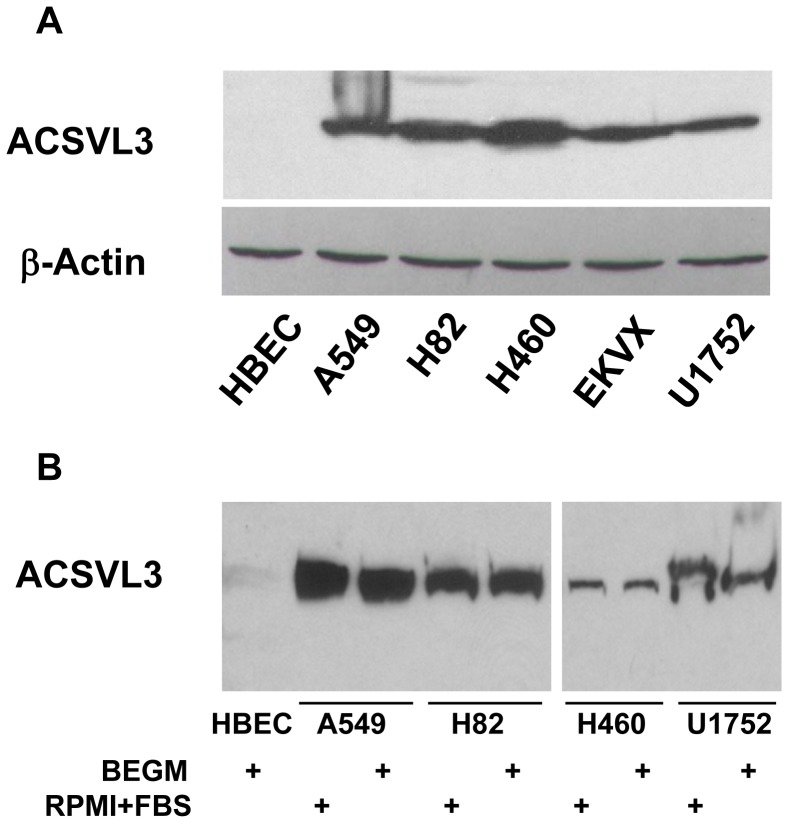
ACSVL3 expression in human bronchial epithelial cells and lung cancer cell lines.(A) Growth under standard culture conditions. HBEC and five lung cancer cell lines were cultured as described in Methods and analyzed for ACSVL3 expression by Western blot. Tumor cell lines were derived from non-small cell carcinoma (A549), small cell carcinoma (H82), large cell carcinoma (H460), adenocarcinoma (EKVX), and squamous cell carcinoma (U1752). β-Actin expression was determined as a loading control. (B) Effect of growth rate reduction on ACSVL3 expression in lung cancer cell lines. HBEC, cultured in serum-free BEGM, grow significantly slower than cancer cell lines. To slow their growth rates, A549, H82, H460, and U1752 cells were transferred to BEGM. All cells were maintained in this medium for 3 weeks, at which time they were harvested and subjected to Western blot analysis. Tumor cells grown in standard medium, RPMI plus 10% fetal bovine serum (FBS), were harvested for comparison. Growth rates in BEGM for all cancer cell lines were decreased by more than 50%.